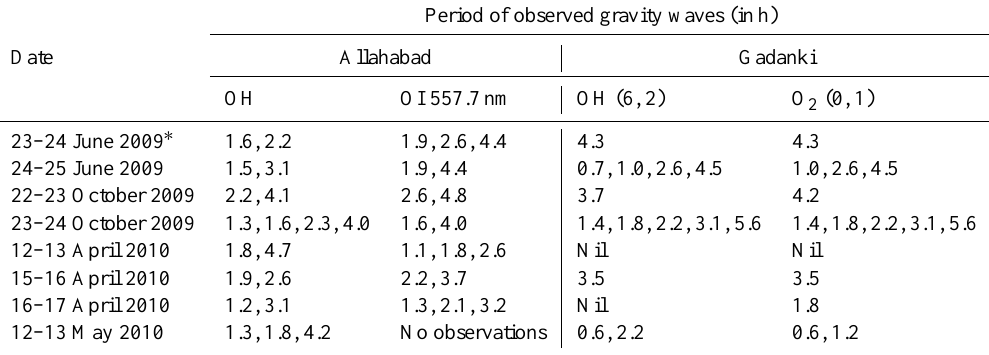
Table 1. Gravity waves observed over Allahabad and Gadanki during the period June 2009 to May 2010. At Allahabad, the waves that were consistently identified at all sample locations are listed. Period of observed gravity waves